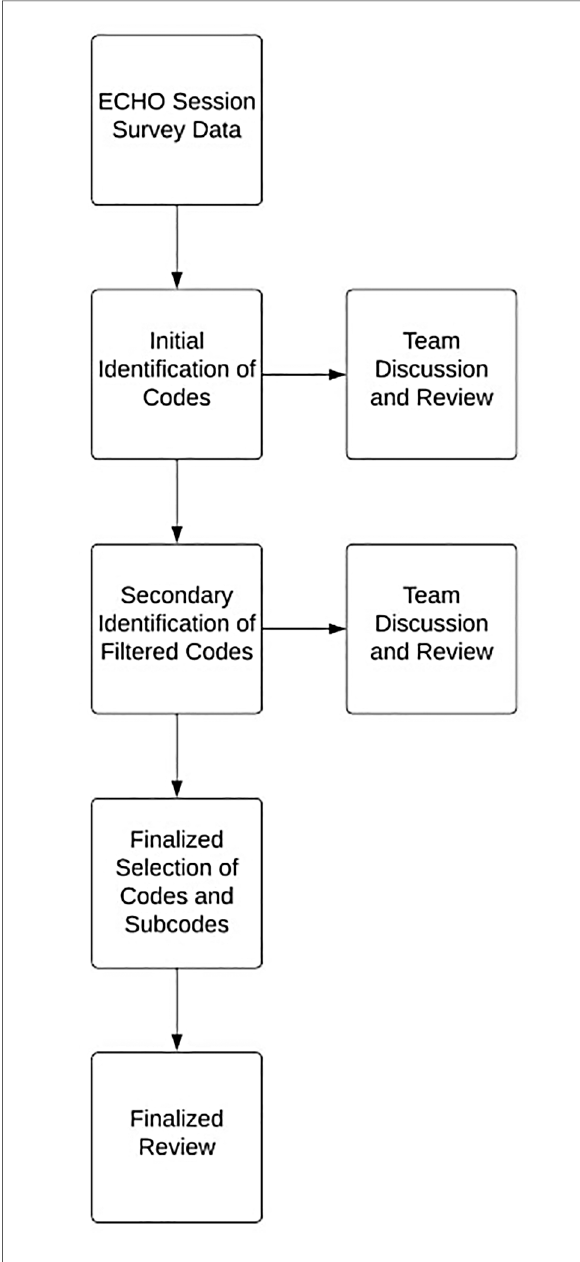
FIGURE 1 Flow chart illustrating the stepwise thematic analysis